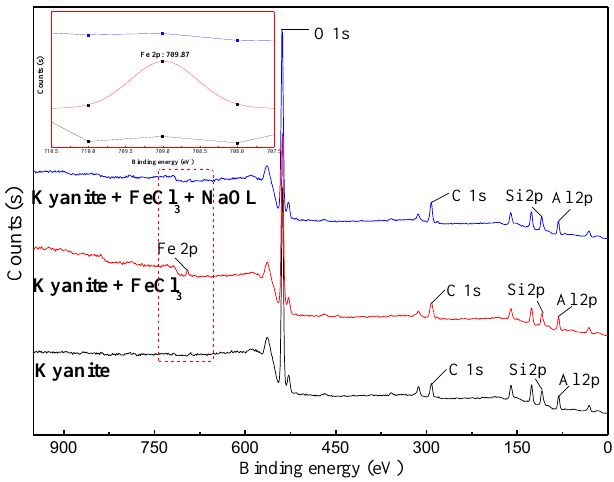
Figure 7. Binding energy of kyanite with and without regulator treatment.